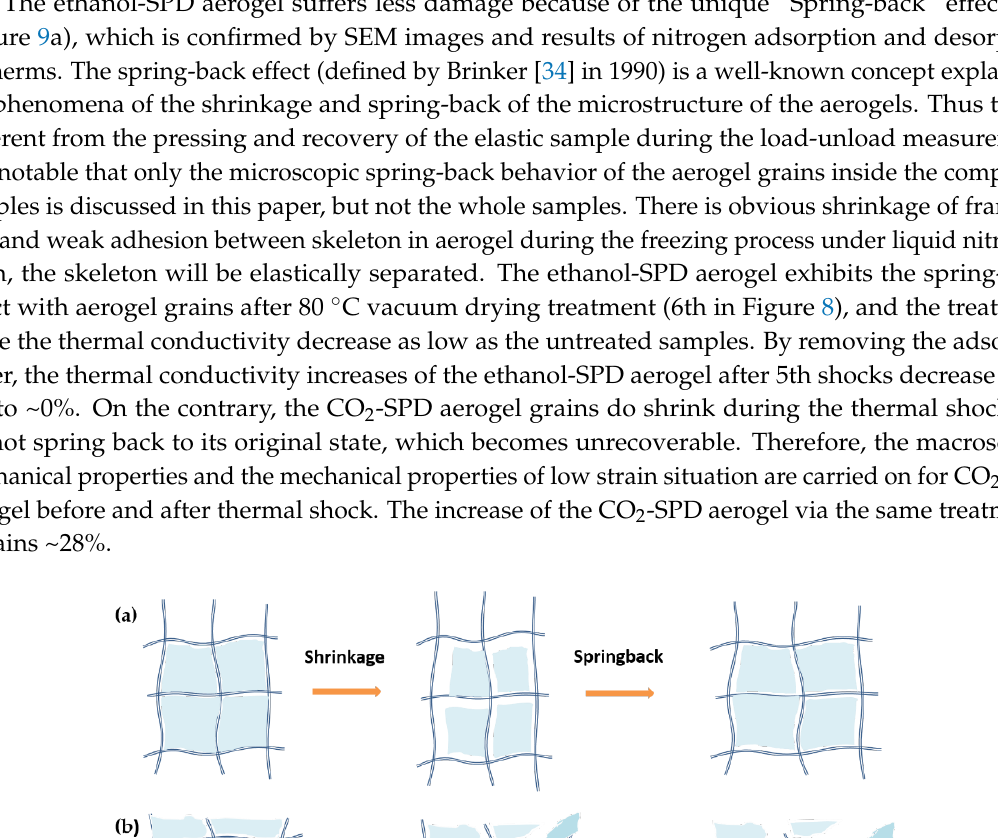
Figure 8. Thermal conductivity changing with cycle times with vacuum drying process.